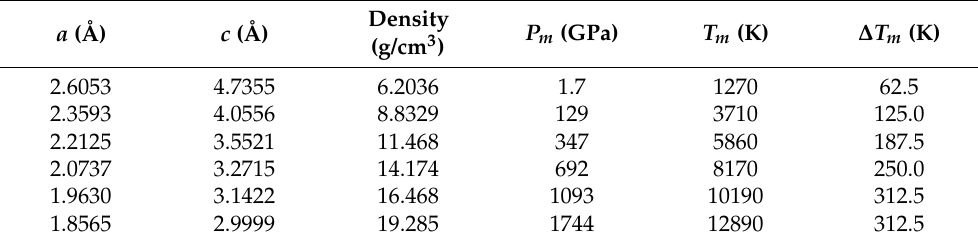
Table 2. The six ab initio melting points of hcp-Cr, ( P m , T m ± ∆ T m ) , obtained from the Z method implemented with VASP.